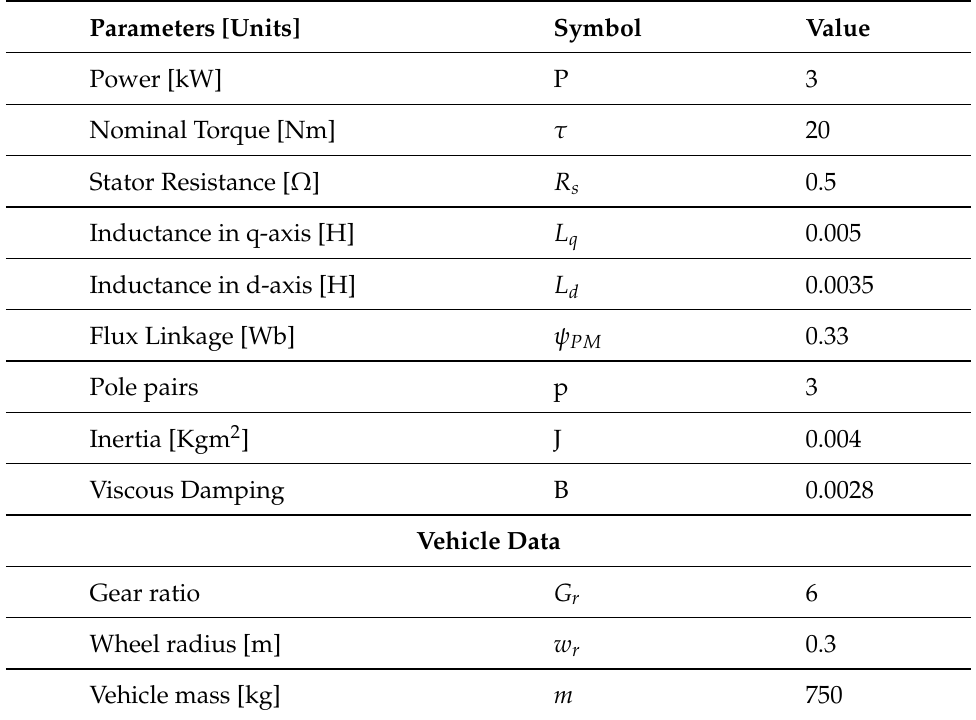
Table 1. IPMSM parameters and EV specification